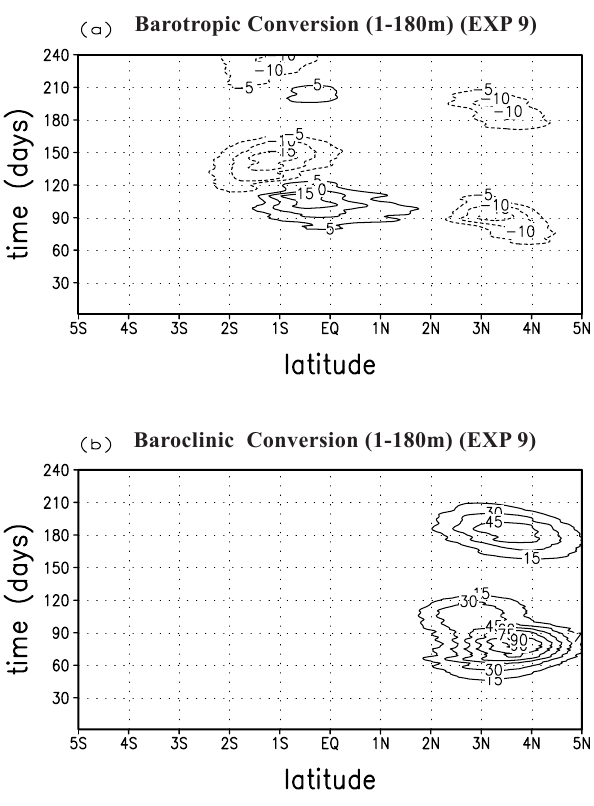
Fig. 9. Time-latitude diagrams of vertically (in the upper 180m) and zonally averaged barotropic conversion (a) and baroclinic con- version (b) for EXP 9. Values are multiplied by 10 6 in both panels and the contour intervals are 5cm 2 /s 3 in (a) and 15cm 2 / s 3 in